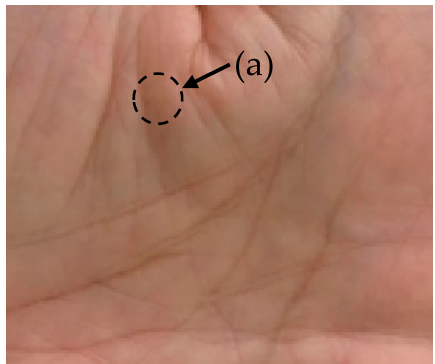
Figure 1. Single frame image of captured video. The dashed circle (a) shows an example of a mottled red pattern also found in other areas of the skin.